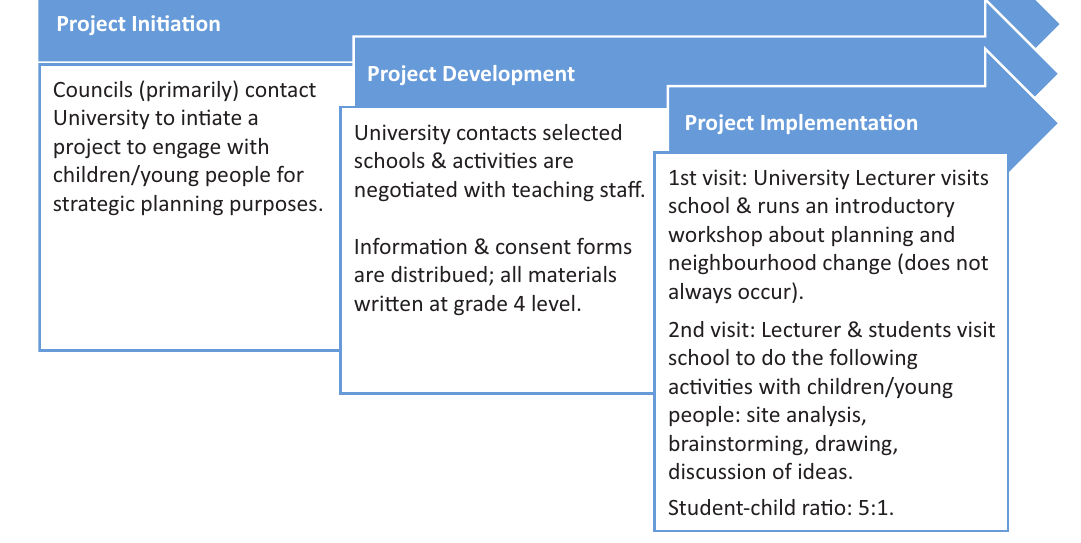
Figure 3. Design project process. vations of how their peers’ use the site, how the site changes in different seasons, etcetera. The session con- cludes after the children/young people have presented their ideas to each other, participating teachers and the Council